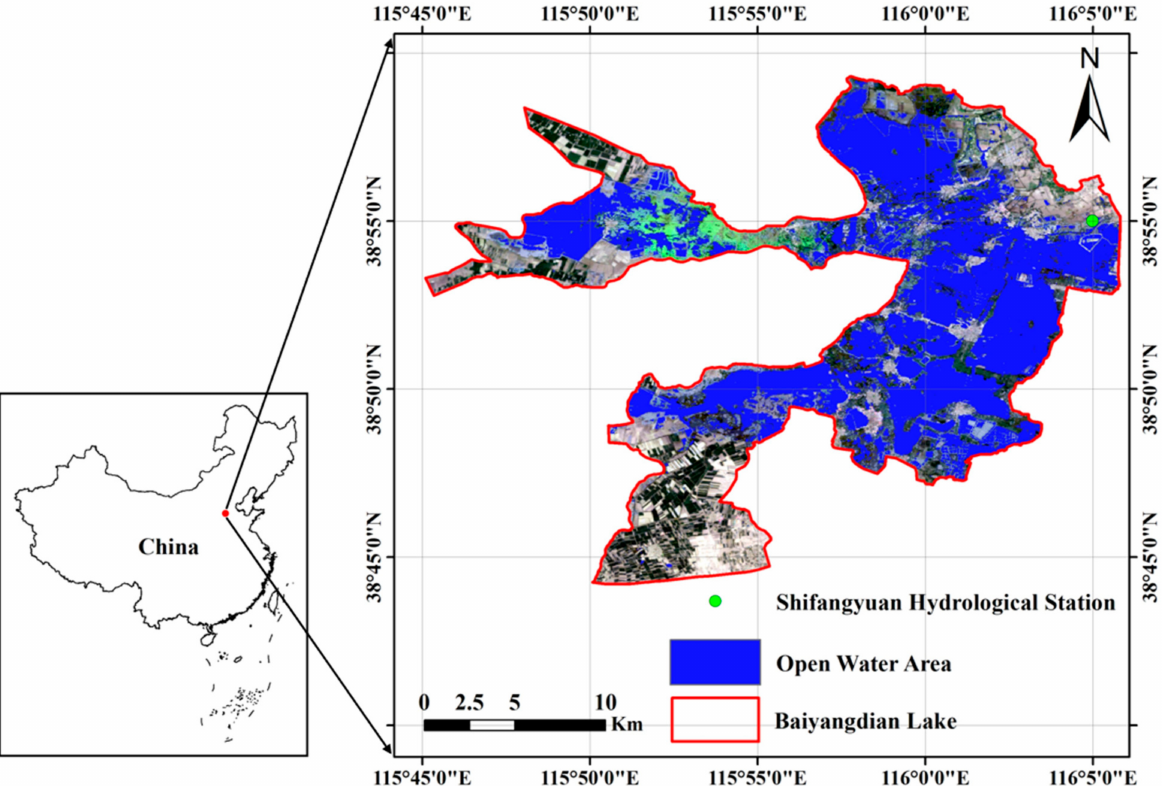
Figure 1. Landsat 8 image of Baiyangdian Lake (acquired on April a29, 2014) and its location in